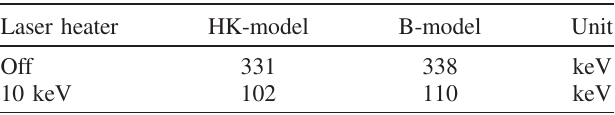
TABLE II. Total uncorrelated energy spread (rms value) at the end of the FERMI linac (see Table I and Figs. 2 and 3). The energy modulation induced by MBI over the initial wavelength range 0 . 5 – 200 μ m is assumed to convert entirely into uncorre- lated energy spread [see Eq.